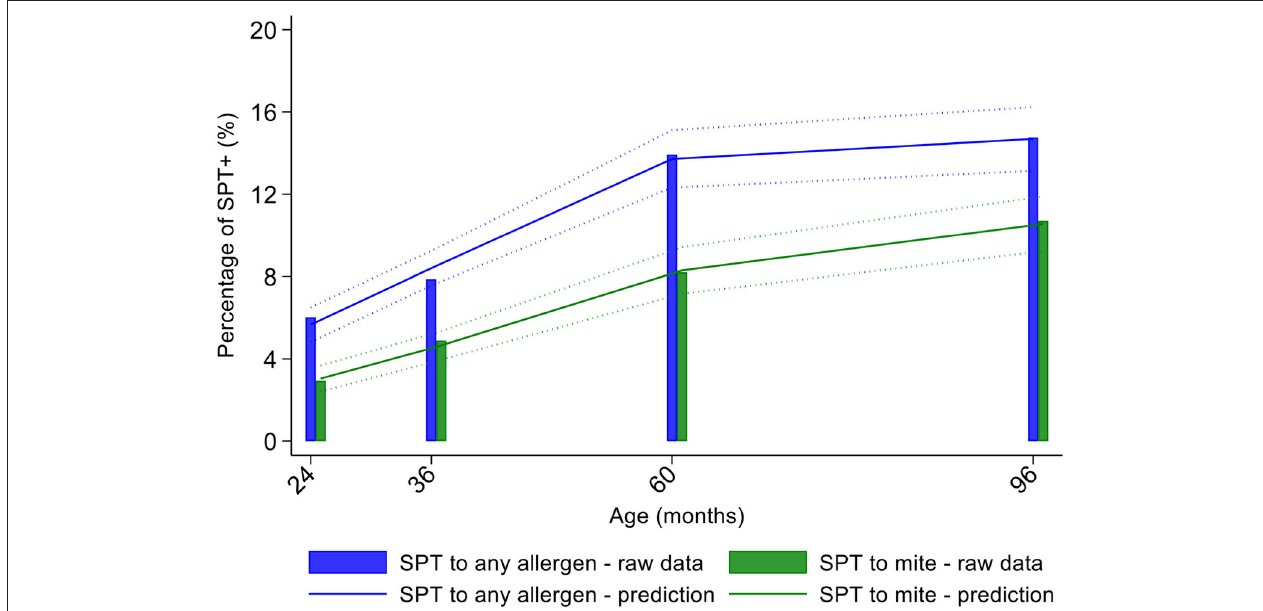
FIGURE 4 | Age-dependent proportions of cohort children with allergen skin prick test positivity (SPT + ) to any allergen (blue) and to mite (green). Shown are predictions from population average longitudinal models (predictions shown by solid lines and 95% confidence intervals by dotted lines) against raw data percentages (bars).